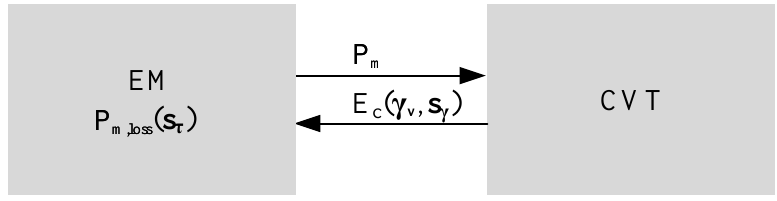
Figure 7. Convex modeling of the EM, where P m represents the EM output power. The EM sizing is performed based on the design variable s τ , because it affects the EM efficiency, weight and cost. For example, reducing the maximum EM torque decreases the usage of active materials of the EM. Note that because of physical limitations of the CVT, the EM speeds above 6500 rpm are not used for the CVT application, which has a negligible impact on the result.